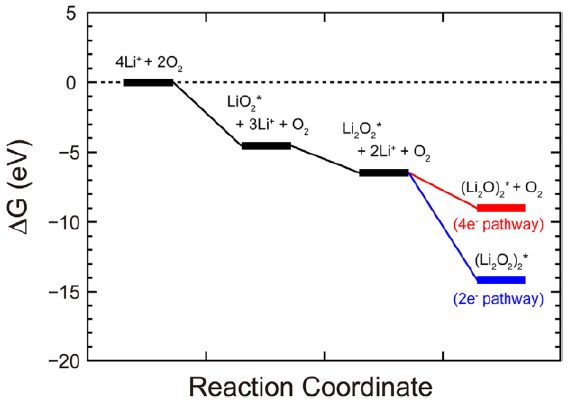
Figure 42. Free energy diagram for the ORR on the h-BN/Ni (111) surface. The black, blue, and red lines denote the reaction steps shared by the two pathways, for the 2e − pathway and for the 4e − pathway, respectively. The asterisk marks the adsorbed states of the ORR intermediates. Reprinted from Lee et al. [84], with permission from Elsevier.